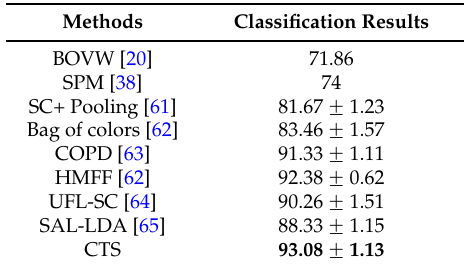
Table 6. Classification result comparison on UC Merced dataset.